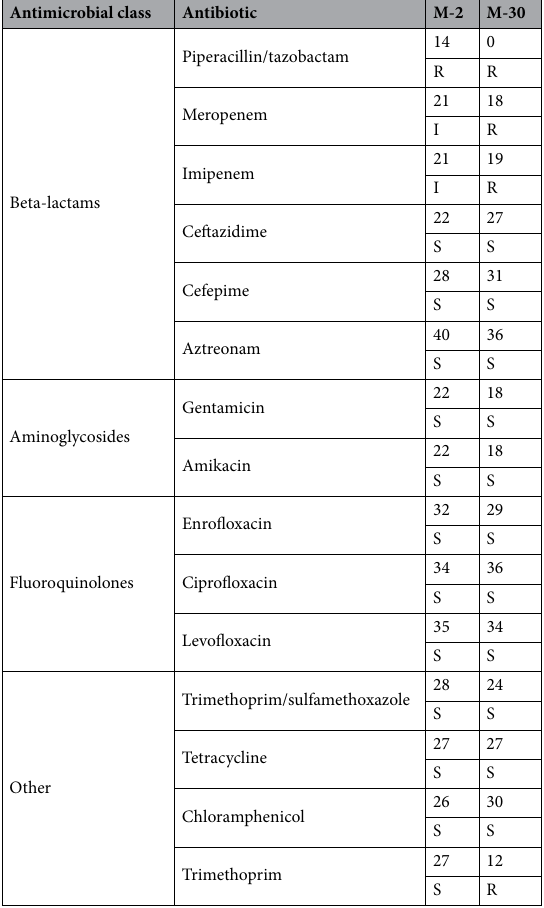
Table 1. List of antimicrobials used and susceptibility pattern with zone diameter in